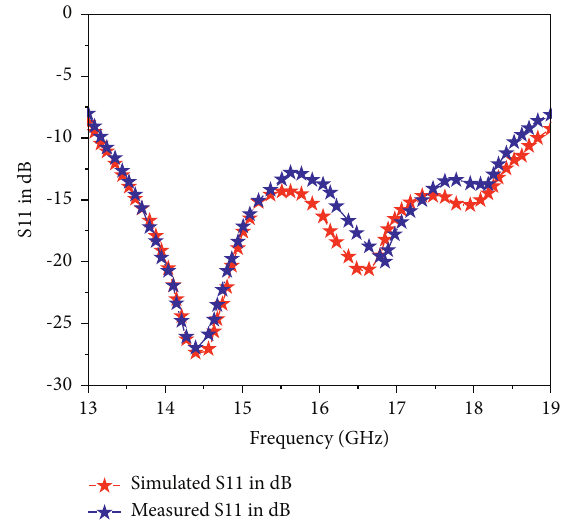
Figure 11: Comparison measured and simulated return loss of the proposed